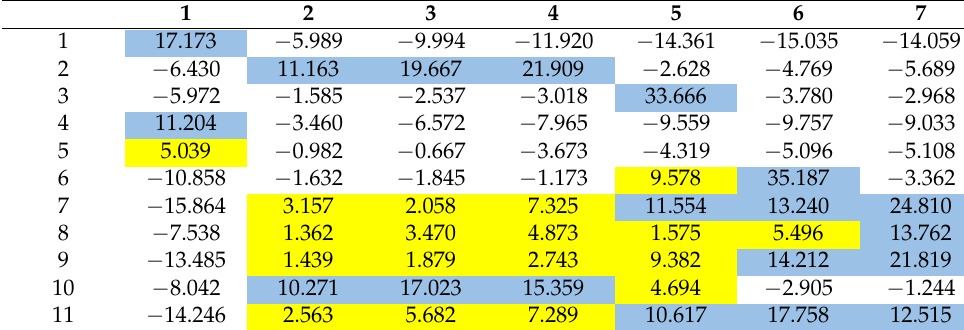
Table A7. Theoretical frequencies DUF 2012 (C1/Class1121).